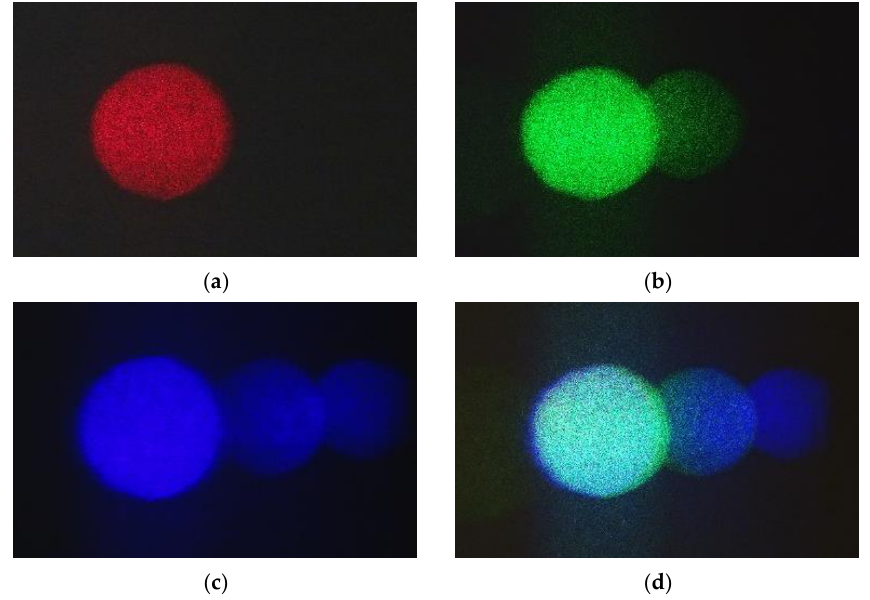
Figure 10. Reconstruction of the multiplexed hologram MH-B of Table 5 with 633 nm (14 ( a )), 532 nm (14 ( b )), 442 nm (14 ( c )) and with the three wavelengths (14 ( d )).